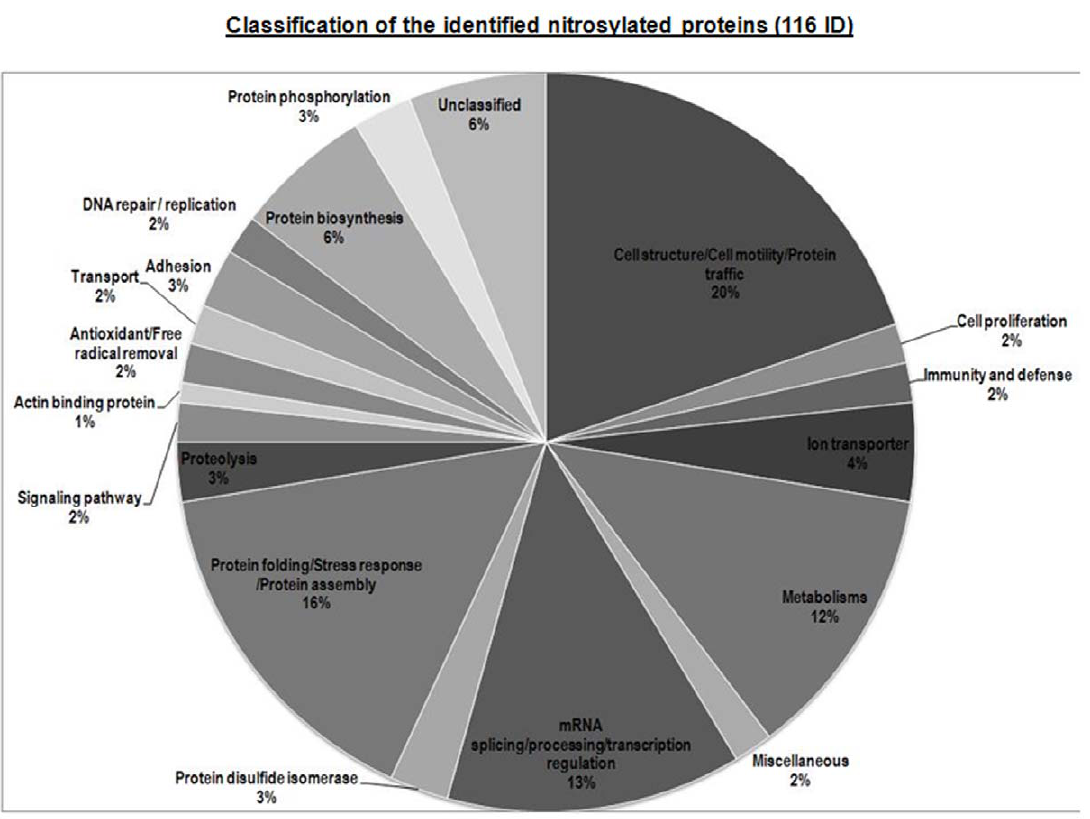
Figure 3. Protein-SNO classification. Proteins that were identified as nitrosylated are grouped according to the biological processes they belong to according to the Panther classification system and listed in Tables S1A and S1B with their biotinylated peptides, if available.